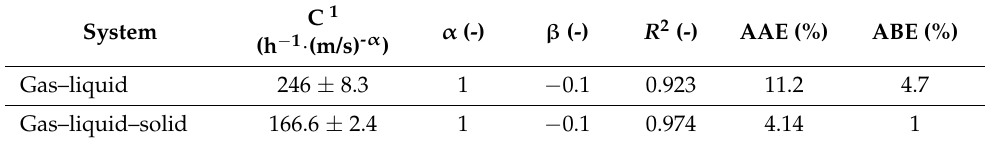
Table 16. Overall volumetric mass transfer coefficient k L a : Evaluated parameters of correlation